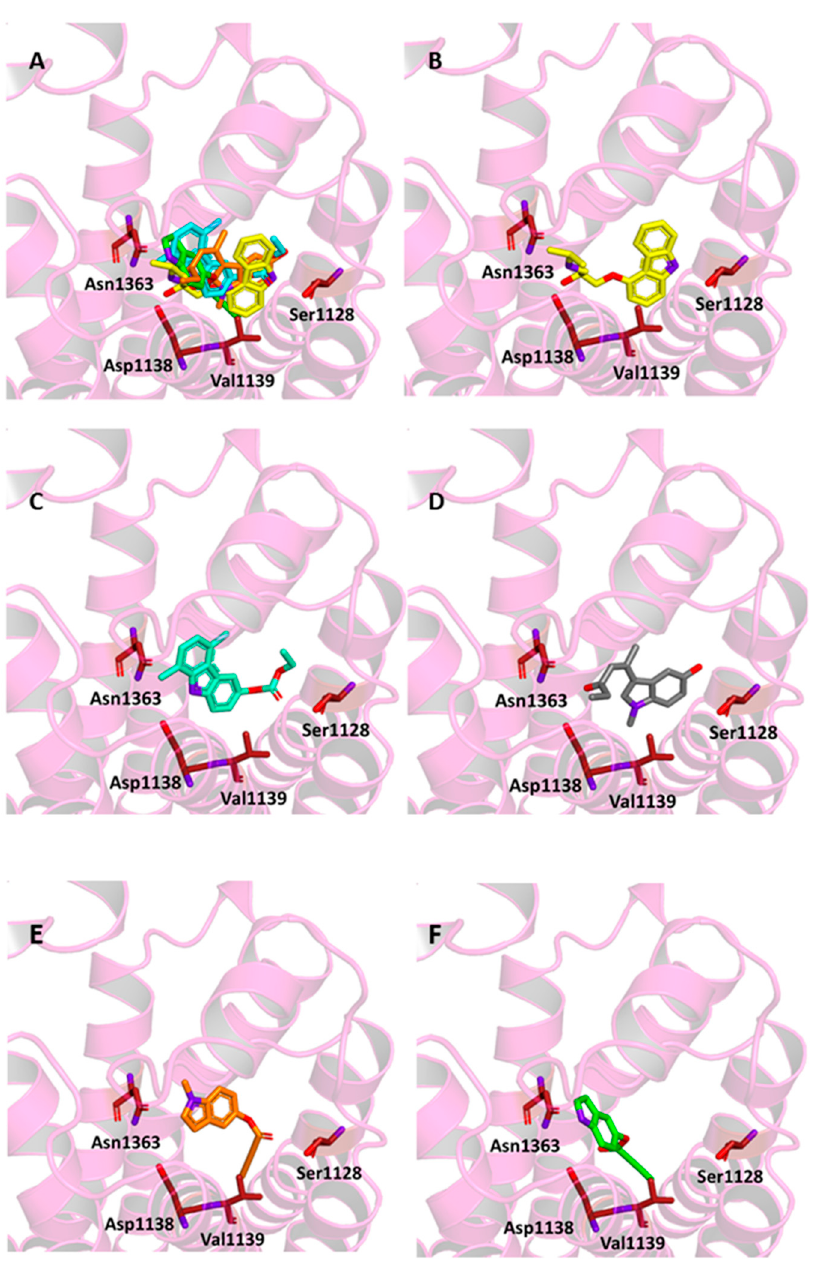
Figure 3. Ligand-binding pocket of the active site of the β 1 adrenergic receptor. The protein backbone is represented in background as ribbons, and the key residues for ligand interaction (Asp1138, Asn1363, Ser1128, Val1139) are also indicated. ( A ) Superimposed binding modes of all the five ligands: carazolol (yellow), 4 (cyan), 7 (grey), 8 (orange) and 10 (green). Specific binding mode of carazolol ( B ), 4 ( C ), 7 ( D ), 8 ( E ) and 10 ( F ).